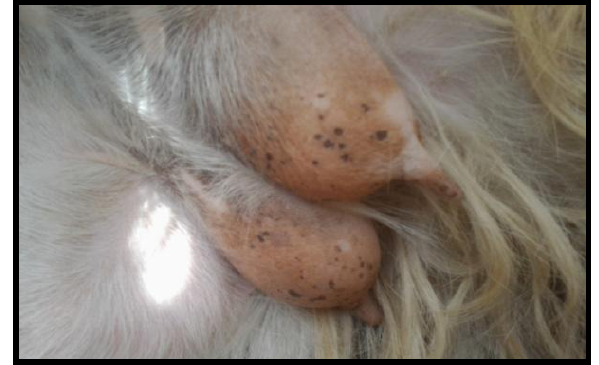
Figure, 4: The slight increase in the size of injected halves in goat of the 2nd group at the beginning of study but less than infected